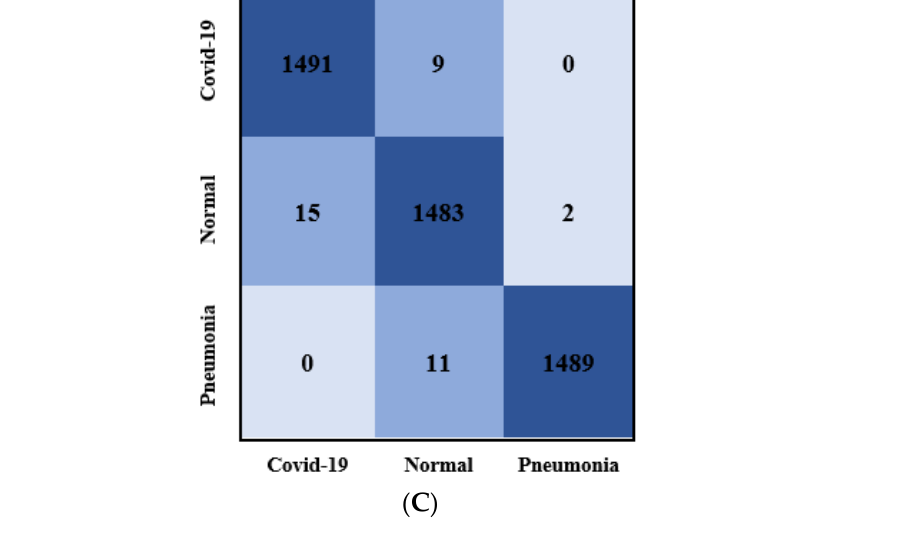
Figure 7. The experimental results include ( A ) ROC and ( B ) PR curve, and ( C ) Confusion Metrics, based on Data_B.